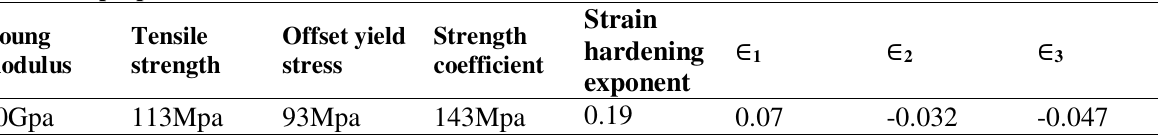
Mechanical properties and values of strains in the tensile